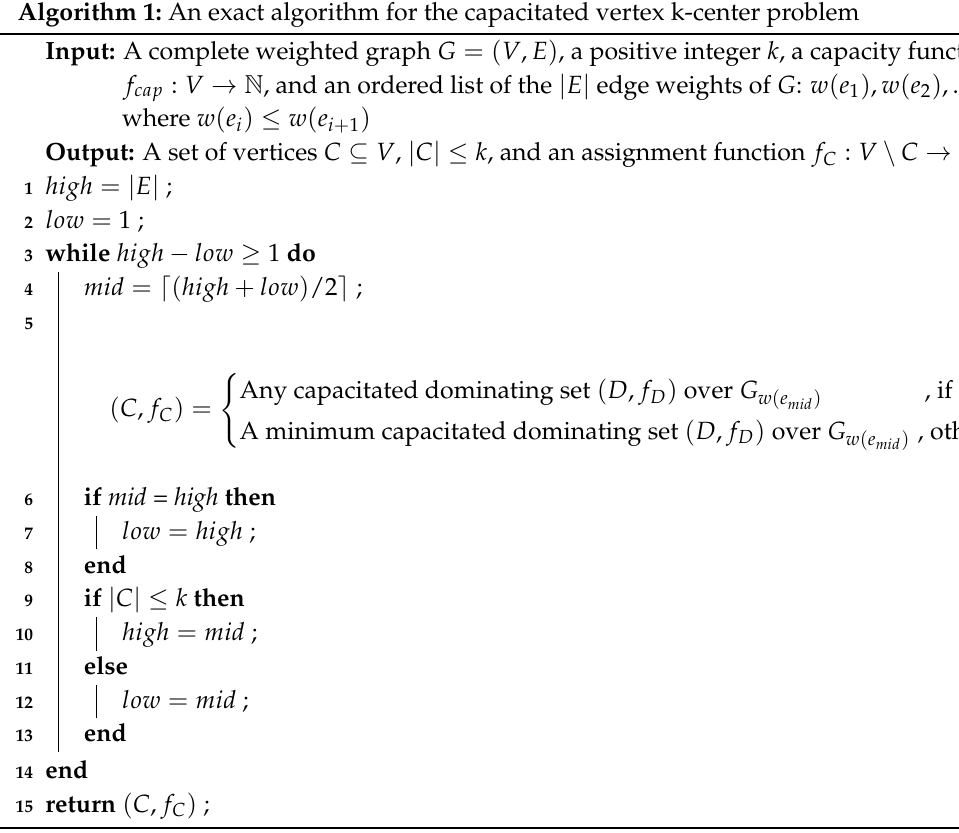
Algorithm 1: An exact algorithm for the capacitated vertex k-center